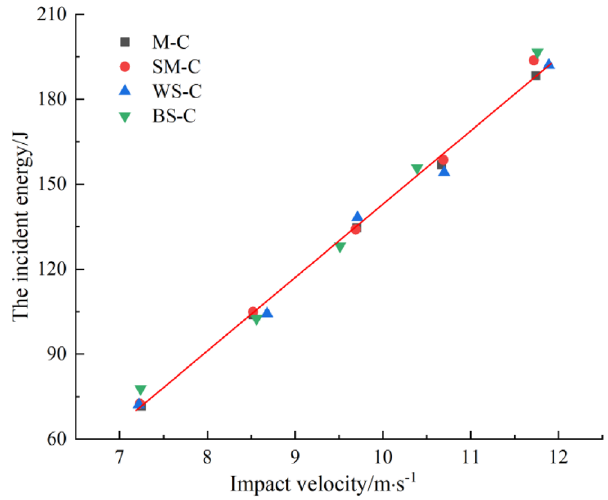
Figure 8. The relationship between impact velocity and incident energy.